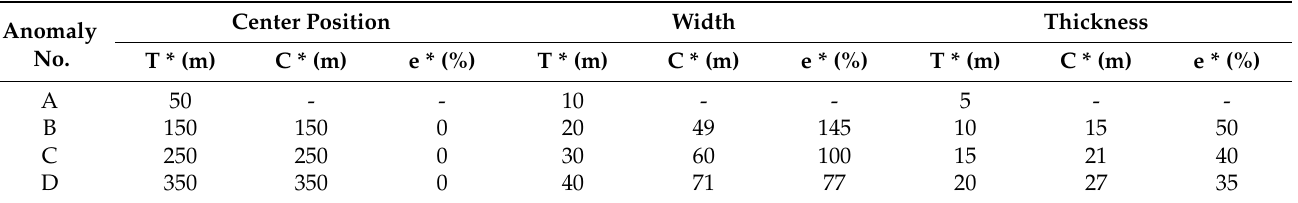
Table 4. Comparing the dimension and position of the four local anomalies shown on the conventional tomogram (Figure 8a) to those shown on the true model (Figure 7).